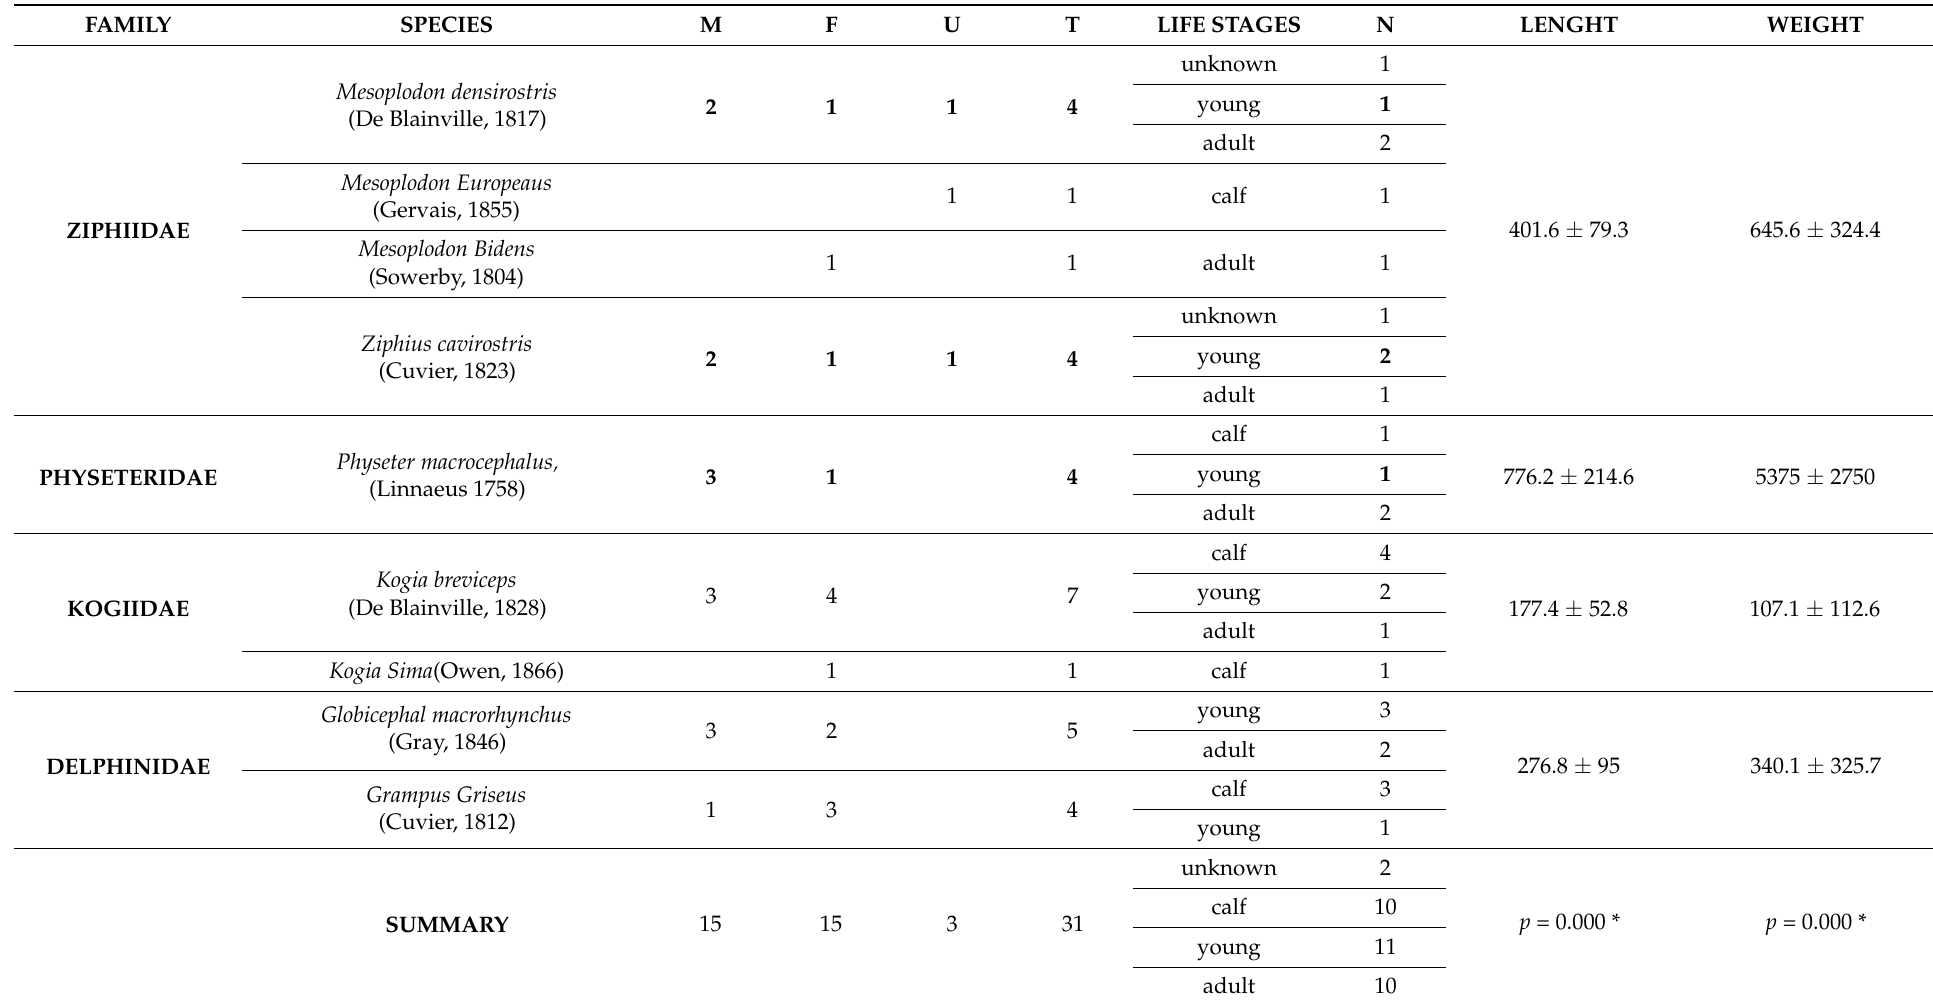
Table 1. Summary of species, sex, life history categories, body length, and mass of the studied cetaceans. M: male, F: female, U: unknown, T: total cases, N: number of samples. * Kruskal–Wallis